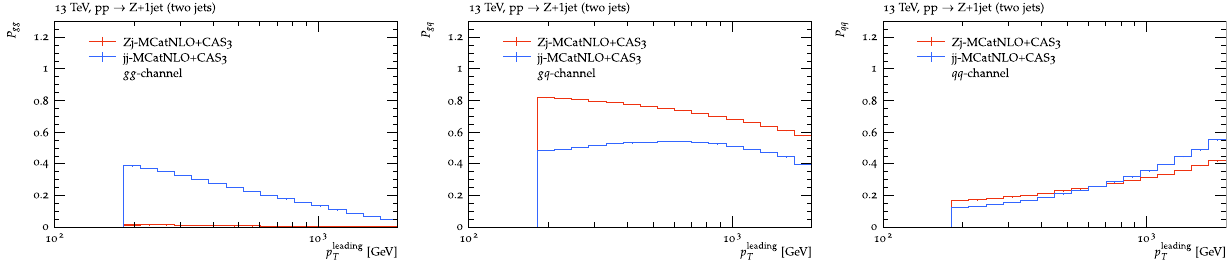
Fig. 4 The probability of gg , qg and qq initial states in Z + jet and multijet production ( q stands for quark and antiquark) as a function of p leading The predictions are calculated with MCatNLO+CAS3